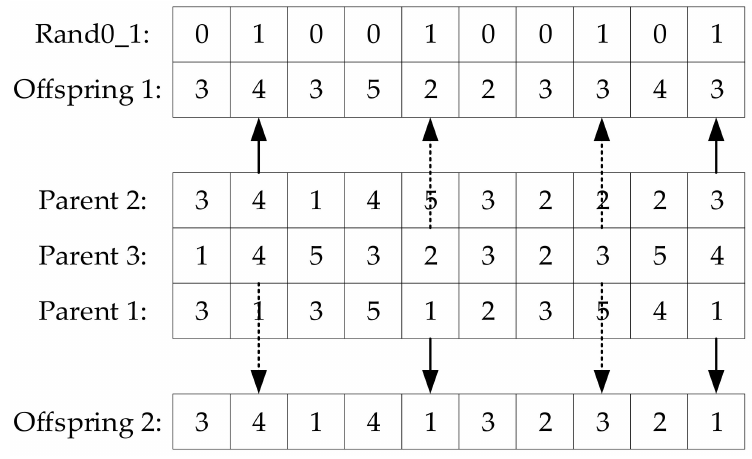
Figure 9. An example for